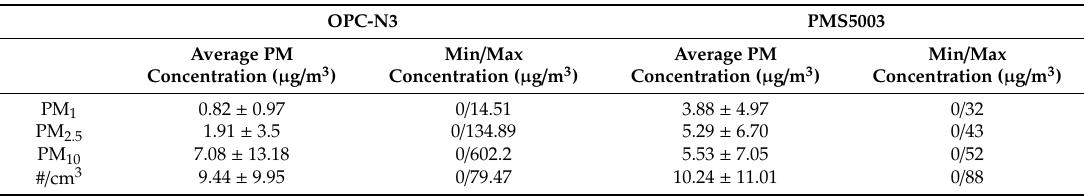
Table 6. Average, minimum, and maximum concentrations of PM 1 , PM 2.5 , and PM 10 obtained during the experimental campaign with the PMS5003 and OPC-N3. OPC-N3 PMS5003 Average PM Min / Max Average PM Min / Max Concentration ( µ g / m 3 ) Concentration ( µ g / m 3 ) Concentration ( µ g / m 3 ) Concentration ( µ g / m 3 ) PM 1 0.82 ± 0.97 0 / 14.51 3.88 ± 4.97